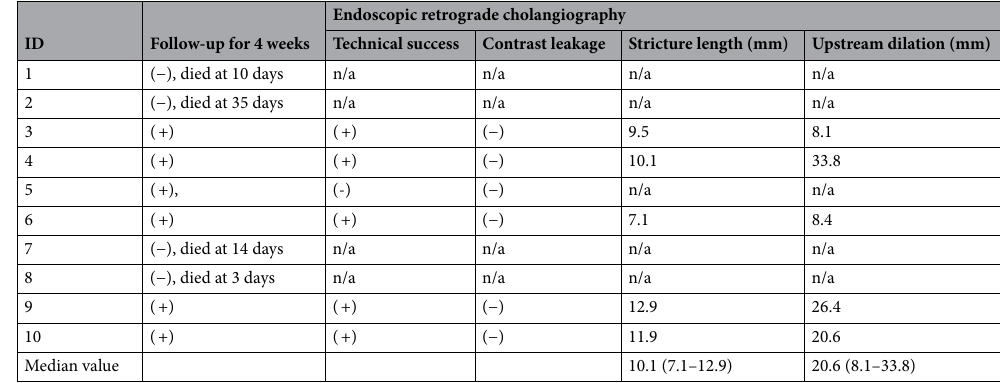
Table 1. Summary of the first in-vivo animal study step. n/a, not applicable. * Circumference of the transverse axis at the widest upstream biliary dilation area.